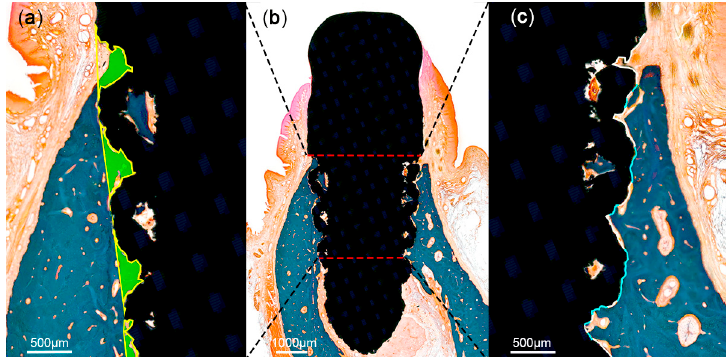
Figure 5. Schematic illustration of histomorphometric analysis in the region of interest (ROI). The ROI was set at the coronal half of each implant ( b ). Areas of the mineralized bone (green) were defined within the implant ( a ). Tissue-to-implant contact within the ROI ( c ) was differentiated into mineralized bone (blue) and void (white).